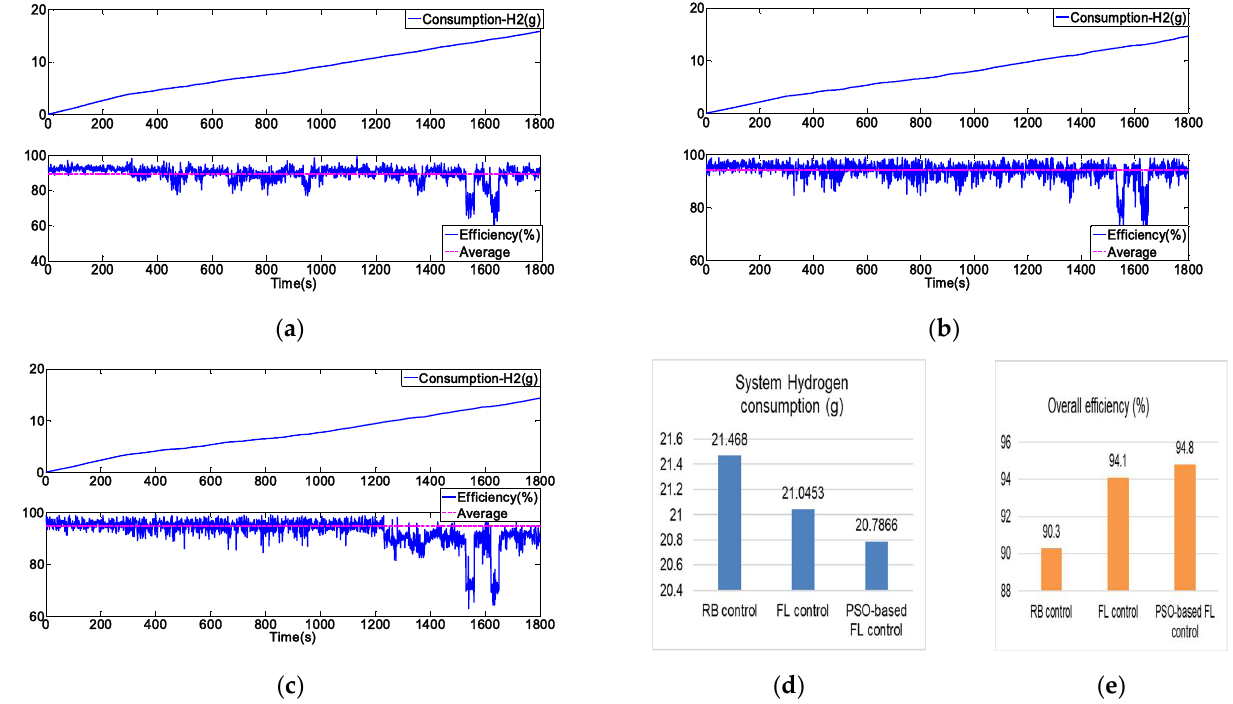
Figure 19. The hydrogen consumption and overall efficiency for three EMS for UAV. ( a ) RB control; ( b ) FL control; ( c ) PSO-based FL control; ( d ) hydrogen consumption; ( e ) overall efficiency.